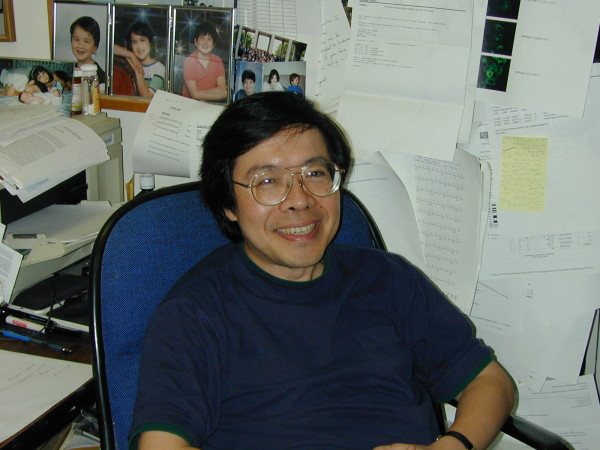
Dr Kuan-Teh Jeang.